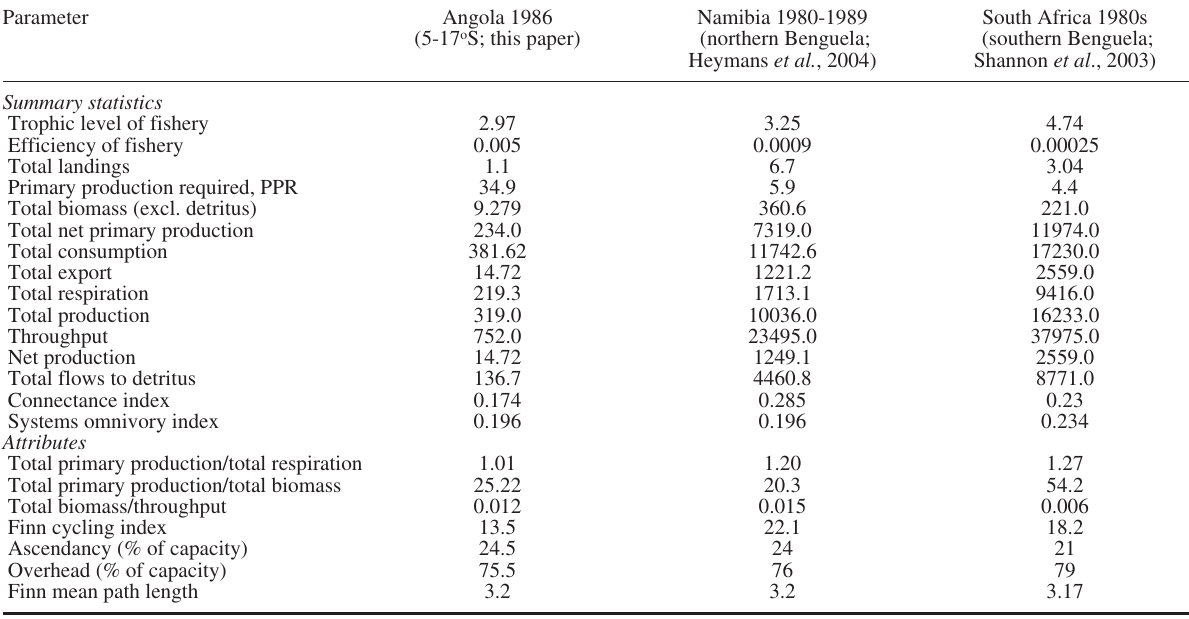
Table 2. – Ecosystem indicators calculated by Ecopath describing the system of Angola (1986) and comparing it with the northern Benguela system – Namibia (Heymans et al. 2004) and the southern Benguela system – South Africa (Shannon et al. 2003). Parameter